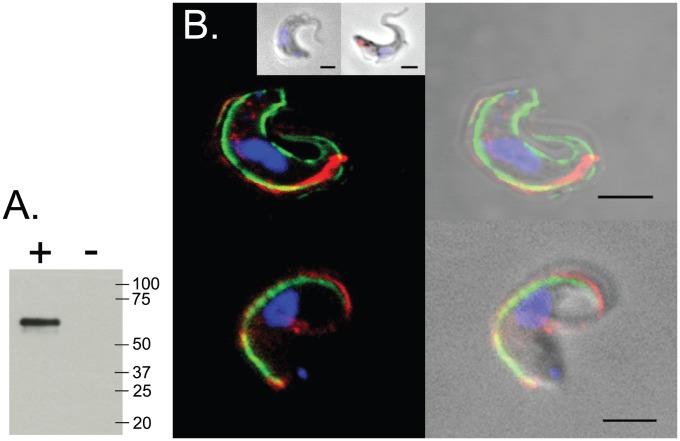
Expression of a Fam50 gene (Tb927.7.380) in T. brucei.
A. Western blot; 2×107 cells were sampled from either induced (+) or uninduced (−) cells after 1-day induction with 1 µg/mL tetracycline. Markers shown in kDa. B. Immunofluorescence analysis of Tb927.7.380 expression in T. brucei, showing co-staining of non-permeabilised cells with plasma membrane protein VSG 221 (top) and PFR2 (bottom). Left: Merged images with color combination for DAPI-stain of the nucleus and kinetoplast (blue), fluorescent stain of HA epitope tag (red) and VSG/PFR fluorescence (green). Right: merged pictures from phase and fluorescence. Inset: co-staining of non-permeabilised and permeabilised cells with Rab11 (intracellular marker). No fluorescence was seen from non-transfected cells (data not shown). GFP expressed from pDEX-577 vector localised to the cytoplasm (data not shown). Scale bar is 2 µm.